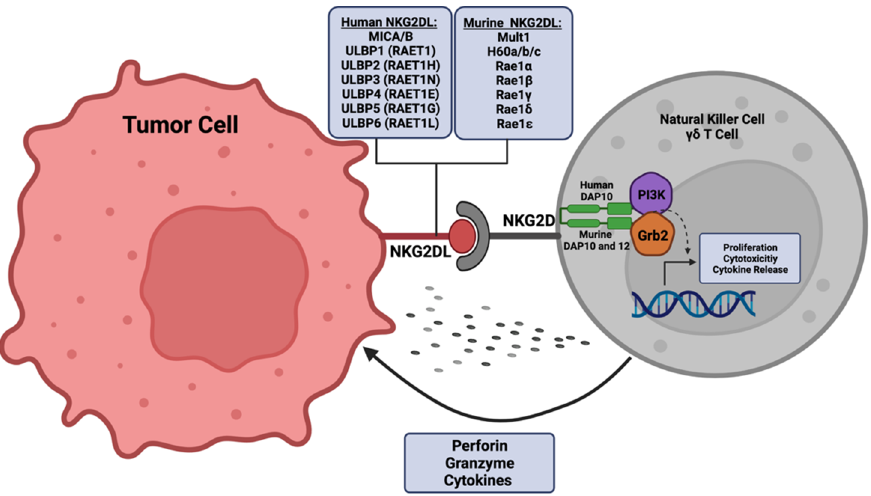
Figure 1. NKG2D ligand (NKG2DL) binding activates the cytotoxic potential of effector cells. In response to stressors, human or murine NKG2D ligands are expressed on the surface of target cells. NKG2D ligands bind to the respective NKG2D receptor found on cells such as natural killer (NK) cells or gamma-delta T cells. Utilizing adaptor molecules DAP10 or DAP12 (murine), the signal transducers, PI3K and Grb2, are recruited to the NKG2D-binding domain. Through intracellular signaling cascades, transcriptional activation of target genes associated with effector cell mainte- nance, including those regulating proliferation, cytotoxicity, and cytokine release, is initiated. Image generated using Biorender.com (accessed on 22 April 2022), licensure certificate available as File S1.